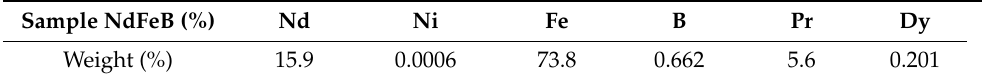
Table 1. Chemical analysis of the powder.